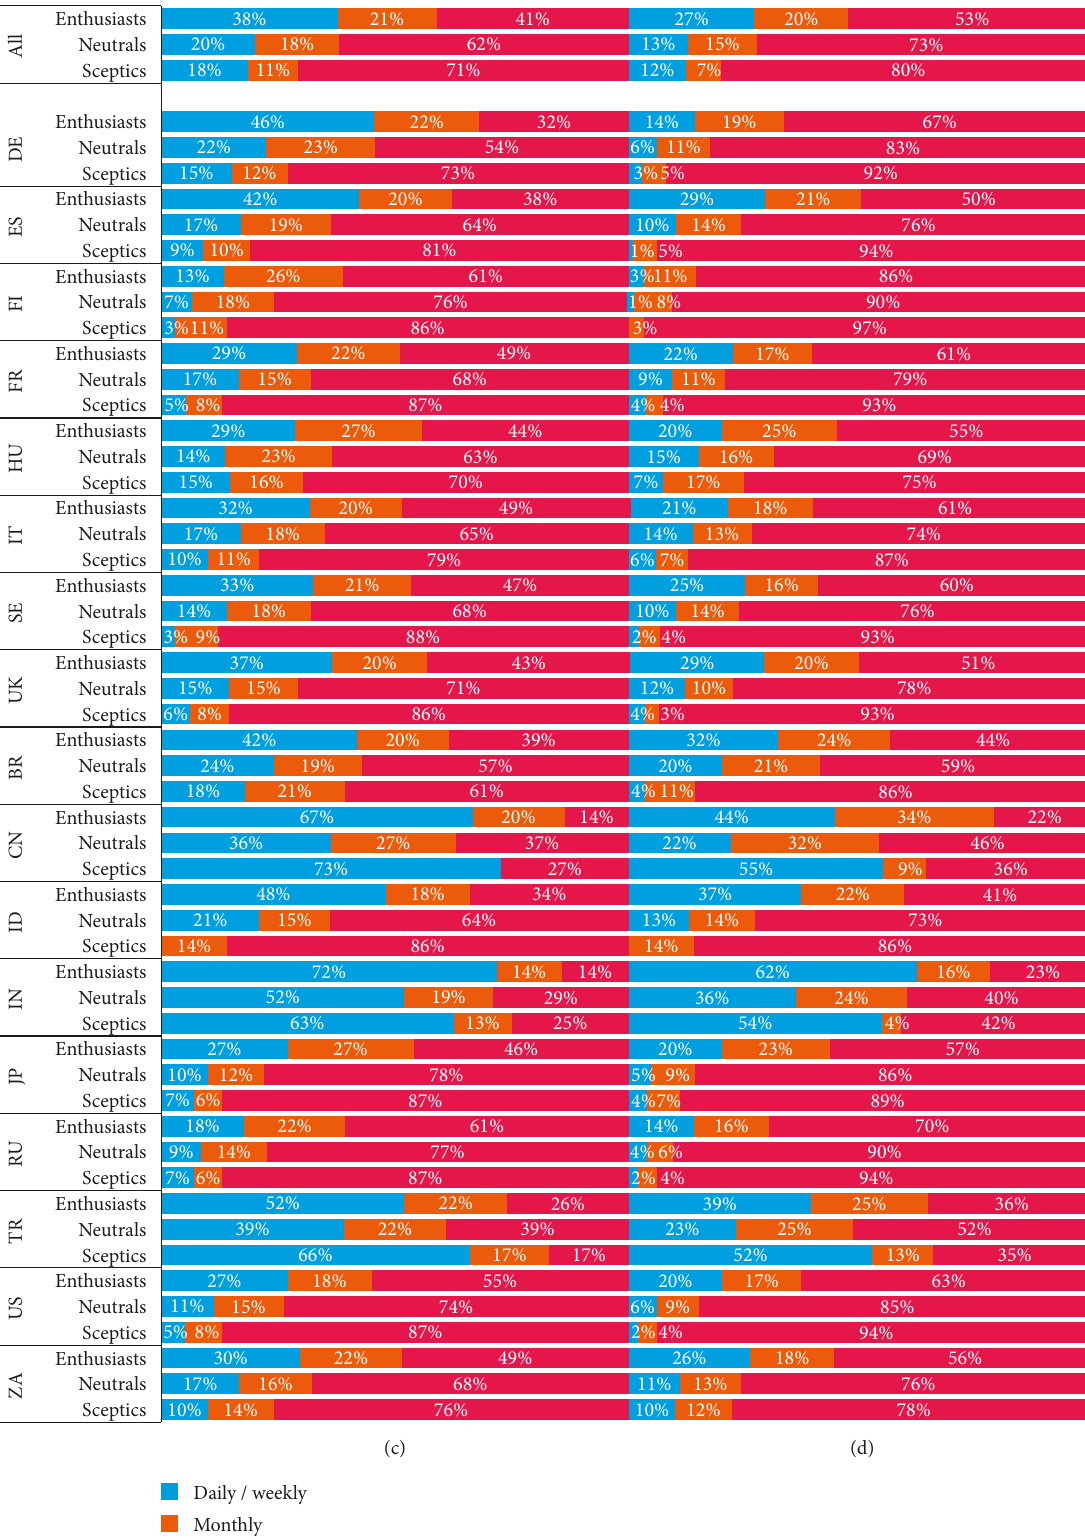
Figure 5: PercentagevaluesofEnthusiasts,Neutrals,andScepticsdifferinginthefrequencyofreceivinginformationaboutautomatedcarsfromonline communities (e.g., blogs and forums), websites about IT, cars or motoring (Q12.1), and social media (e.g., Facebook, Instagram, Twitter, and YouTube) (Q12.2). (b) Percentage values of Enthusiasts, Neutrals, and Sceptics differing in the frequency of receiving information about automated cars from radio, TV (Q12.3), newspapers, and magazines (not online) (Q12.6). (c) Percentage values of Enthusiasts, Neutrals, and Sceptics differing in the frequency of receiving information about automated cars from friends, family members, and colleagues (Q12.4). (d) Percentage values of Enthusiasts, Neutrals, and Sceptics differing in the frequency of receiving information about automated cars from car dealers, manufacturers, and suppliers